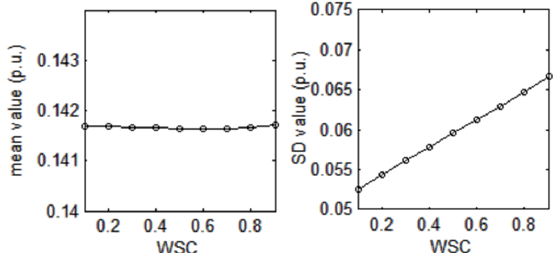
Figure 10. µ - 13 ´ 14 , σ - P 13 ´ 14 of 3-order SG-PLF under different WSC.